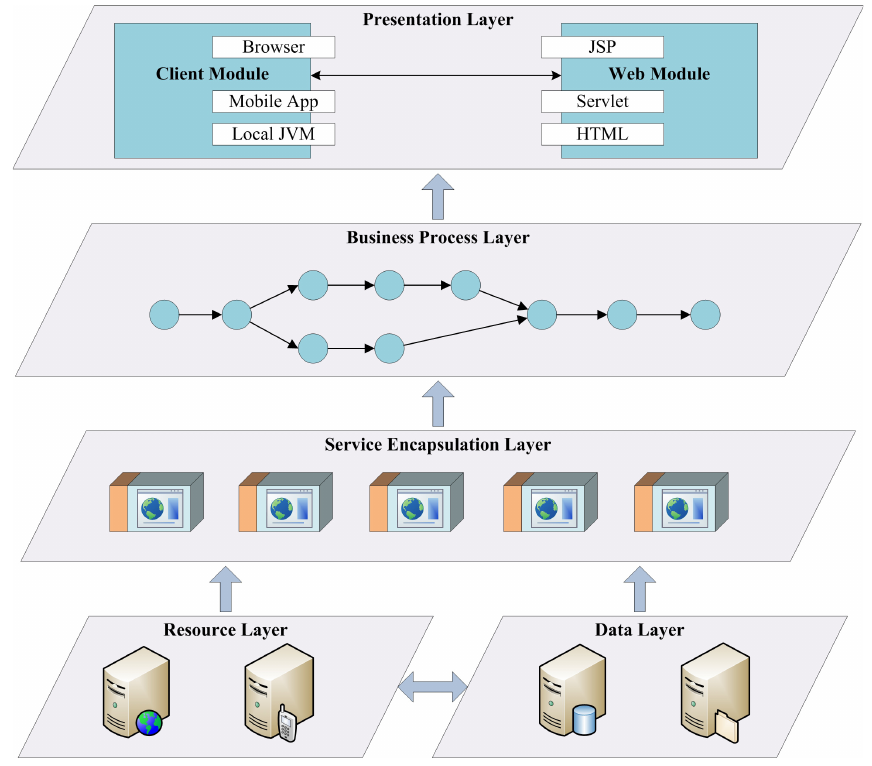
Figure 9. Framework of web service